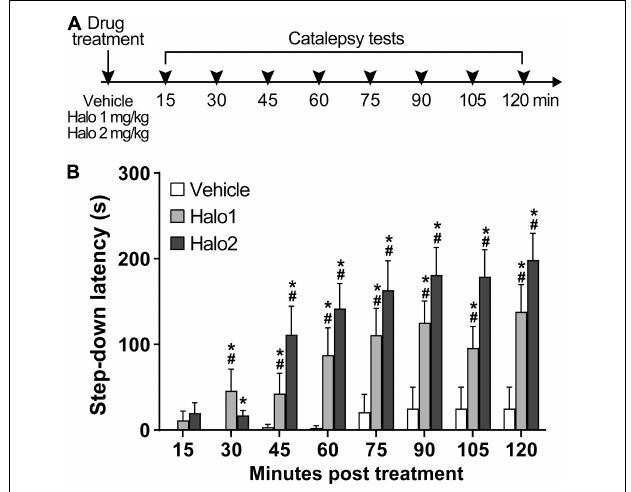
FIGURE 1 | Haloperidol 1 and 2 mg/kg induce long lasting catalepsy when injected i.p. (A) Timeline of the experimental procedure. (B) Step-down latency in groups of rats receiving haloperidol in doses of 1 (Halo1) or 2 mg/kg (Halo2), or vehicle, evaluated after 15, 30, 45, 60, 75, 90, 105, and 120 min after drug administration. Mean + S.E. *Different from the vehicle-treated group in the same time-point. # Different from the same treatment group at 15 min. n = 12 per